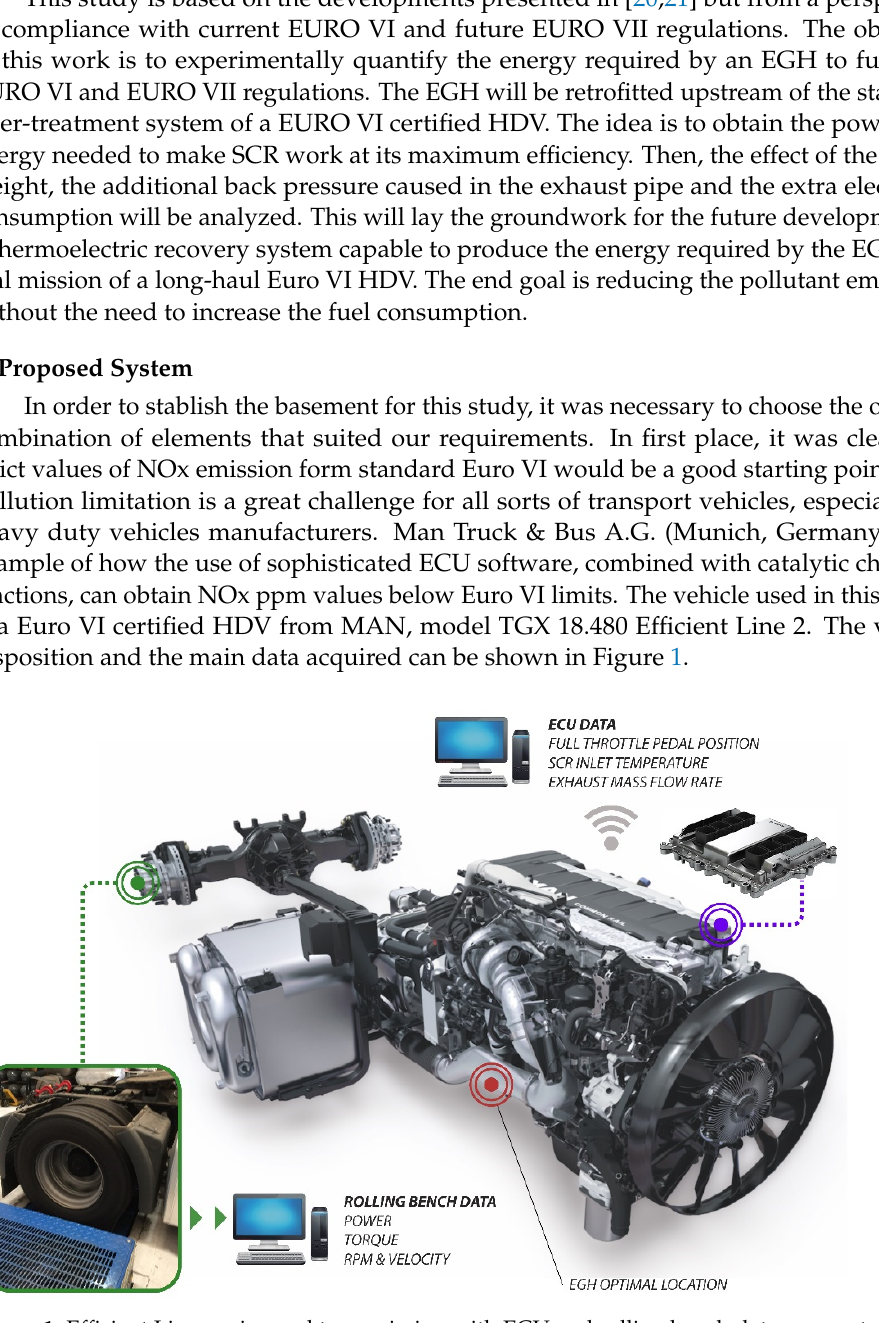
Figure 1. Efficient Line engine and transmission with ECU and rolling bench data parameters.